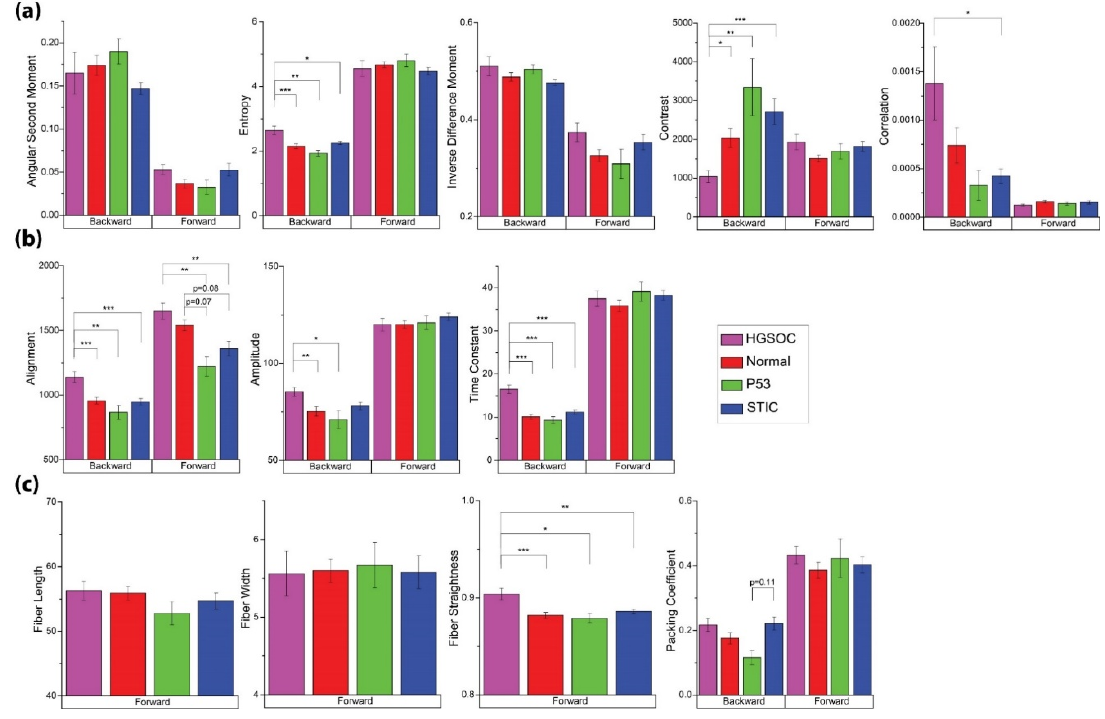
Figure 4. Image and texture features from the analyses given in Table 1 for the four tissue classes of normal, HGSOC, p53, and STIC. ( a ) GLCM features. ( b ) 2D-FFT parameters. ( c ) CT-FIRE outputs and Packing Coefficient. Significant p-values are denoted as follows: * = p < 0.05, ** = p < 0.01, and *** = p < 0.001.